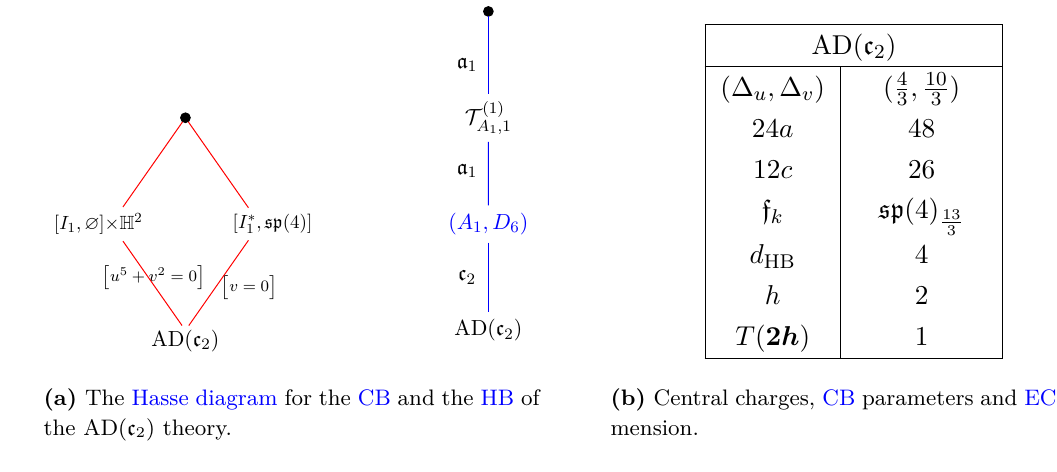
Figure 39. Information about the AD( c 2 )